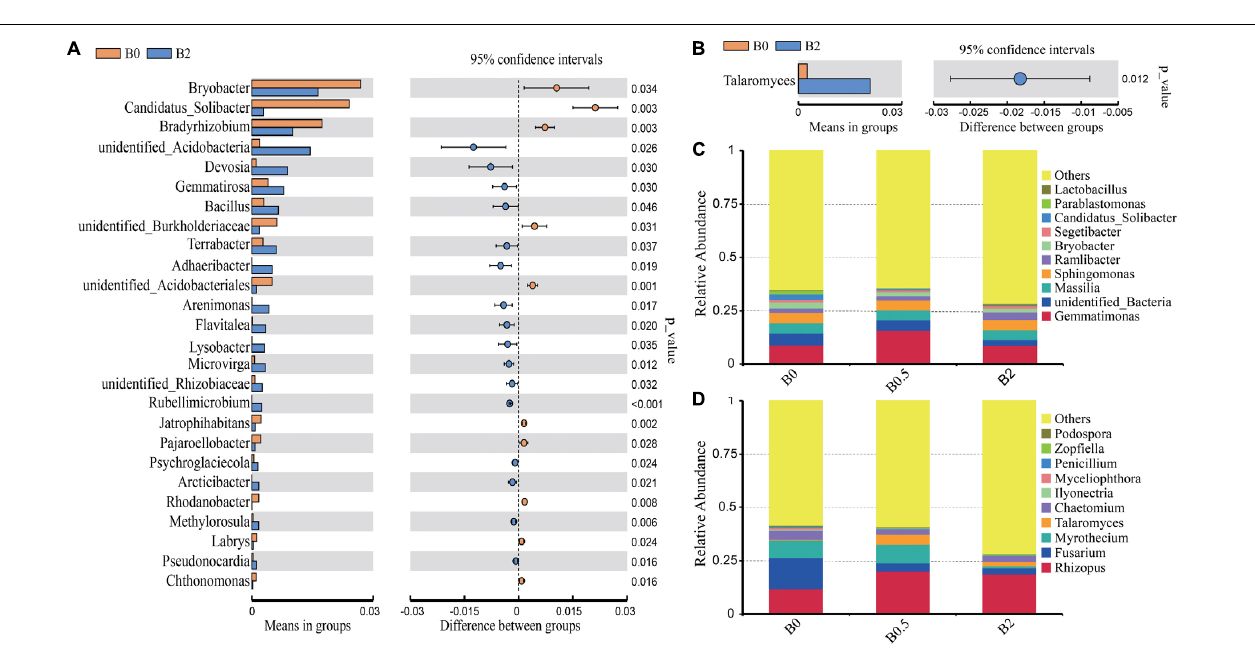
Frontiers in Microbiology |